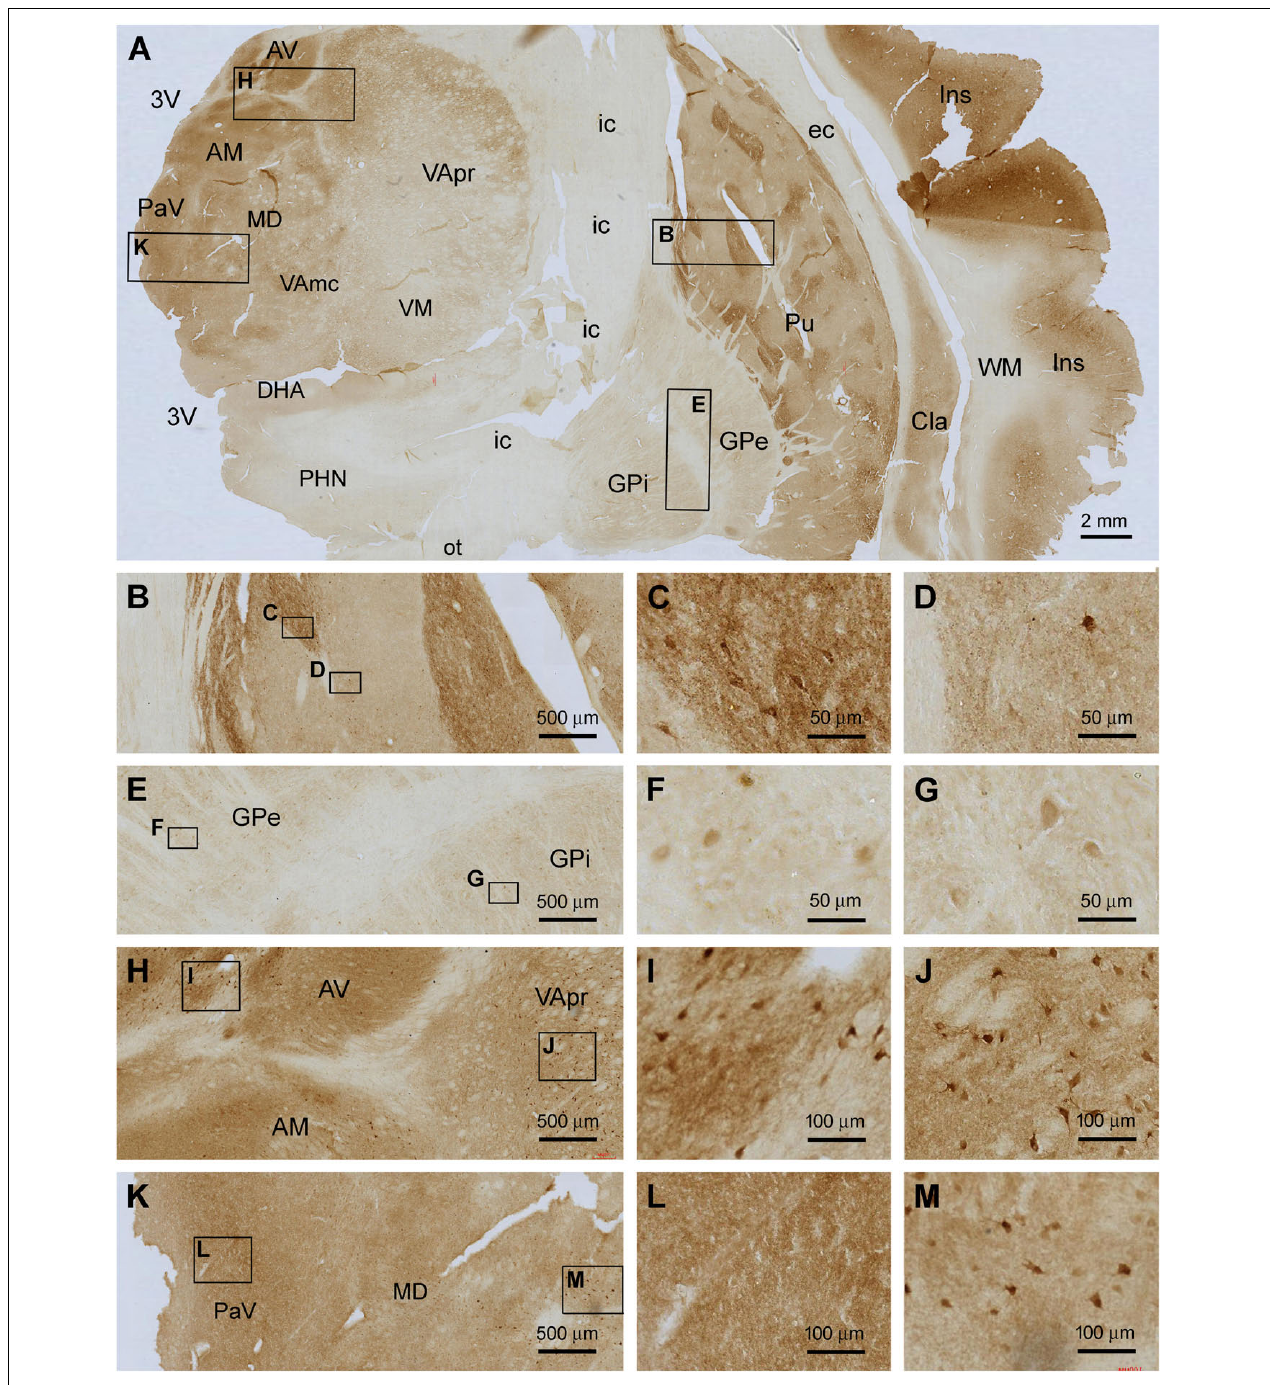
FIGURE 5 | Localization of Shank3 IR in subregions of the basal ganglia and diencephalon. Panel (A) is a micrograph of the immunolabeled section passing the insula (Ins), striatum and thalamus, with framed areas enlarged as (B–M) . Shank3 IR in the putamen (Pu) displays a patching pattern, with strong labeling occurred in local areas separated by areas with much lighter staining. The former areas contain greater neuropil reactivity than the latter, whereas large-sized multipolar neurons are present in both areas (B–D) . Shank3 IR in the globus pallidus (GP) is much lower relative to the Pu and comparable between its external (GPe) and internal (GPe) subdivisions, both containing lightly stained neuropil and neuronal perikarya (E–G) . In the thalamus, the overall intensity of Shank3 IR is greater in the medial than the lateral regions (A) . The labeling occurs in the neuropil as well as neuronal somata (H–M) . No Shank3 IR is present in the white matter (WM), neural tracts or fiber bundles. AV, anterior ventral thalamic nucleus; AM, anterior medial thalamic nucleus; MD, mediodorsal nucleus of thalamus; VA, ventral anterior nucleus of thalamus; VApr, parvocellular division of VA; VAmc, magnocellular division of VA; PaV, paraventricular thalamic nuclei; VM, ventromedial thalamic nucleus; DHA, dorsal hypothalamic area; PHN, posterior hypothalamic nucleus; Cla, claustrum; EC, external capsule; IC, internal capsule; Cpd, cerebral peduncle; OT, optic tract; 3V, third ventricle. Scale bars are as indicated in each